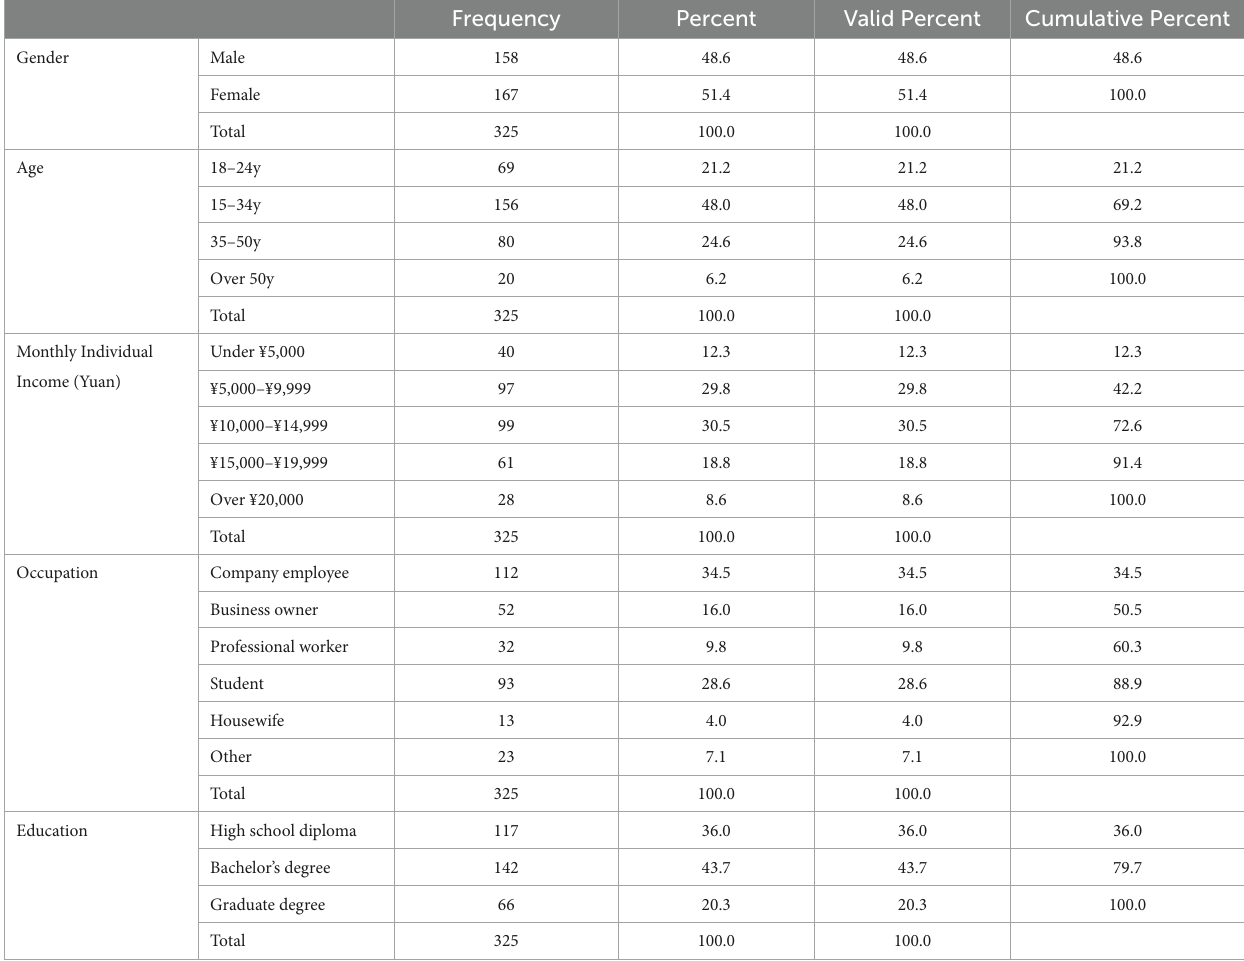
TABLE 1 Sociodemographic analysis of the sample ( n =